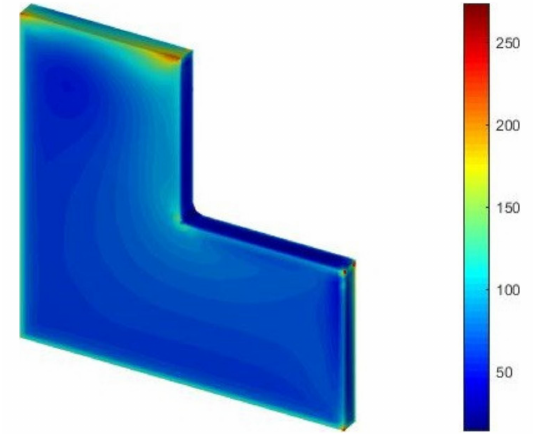
Figure 18. Initial structural stress